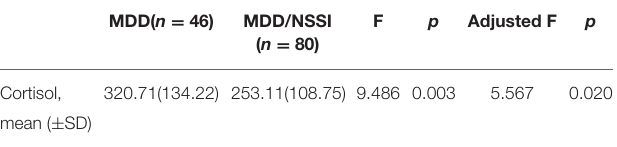
TABLE 2 | Serum cortisol in MDD patients with and without NSSI.